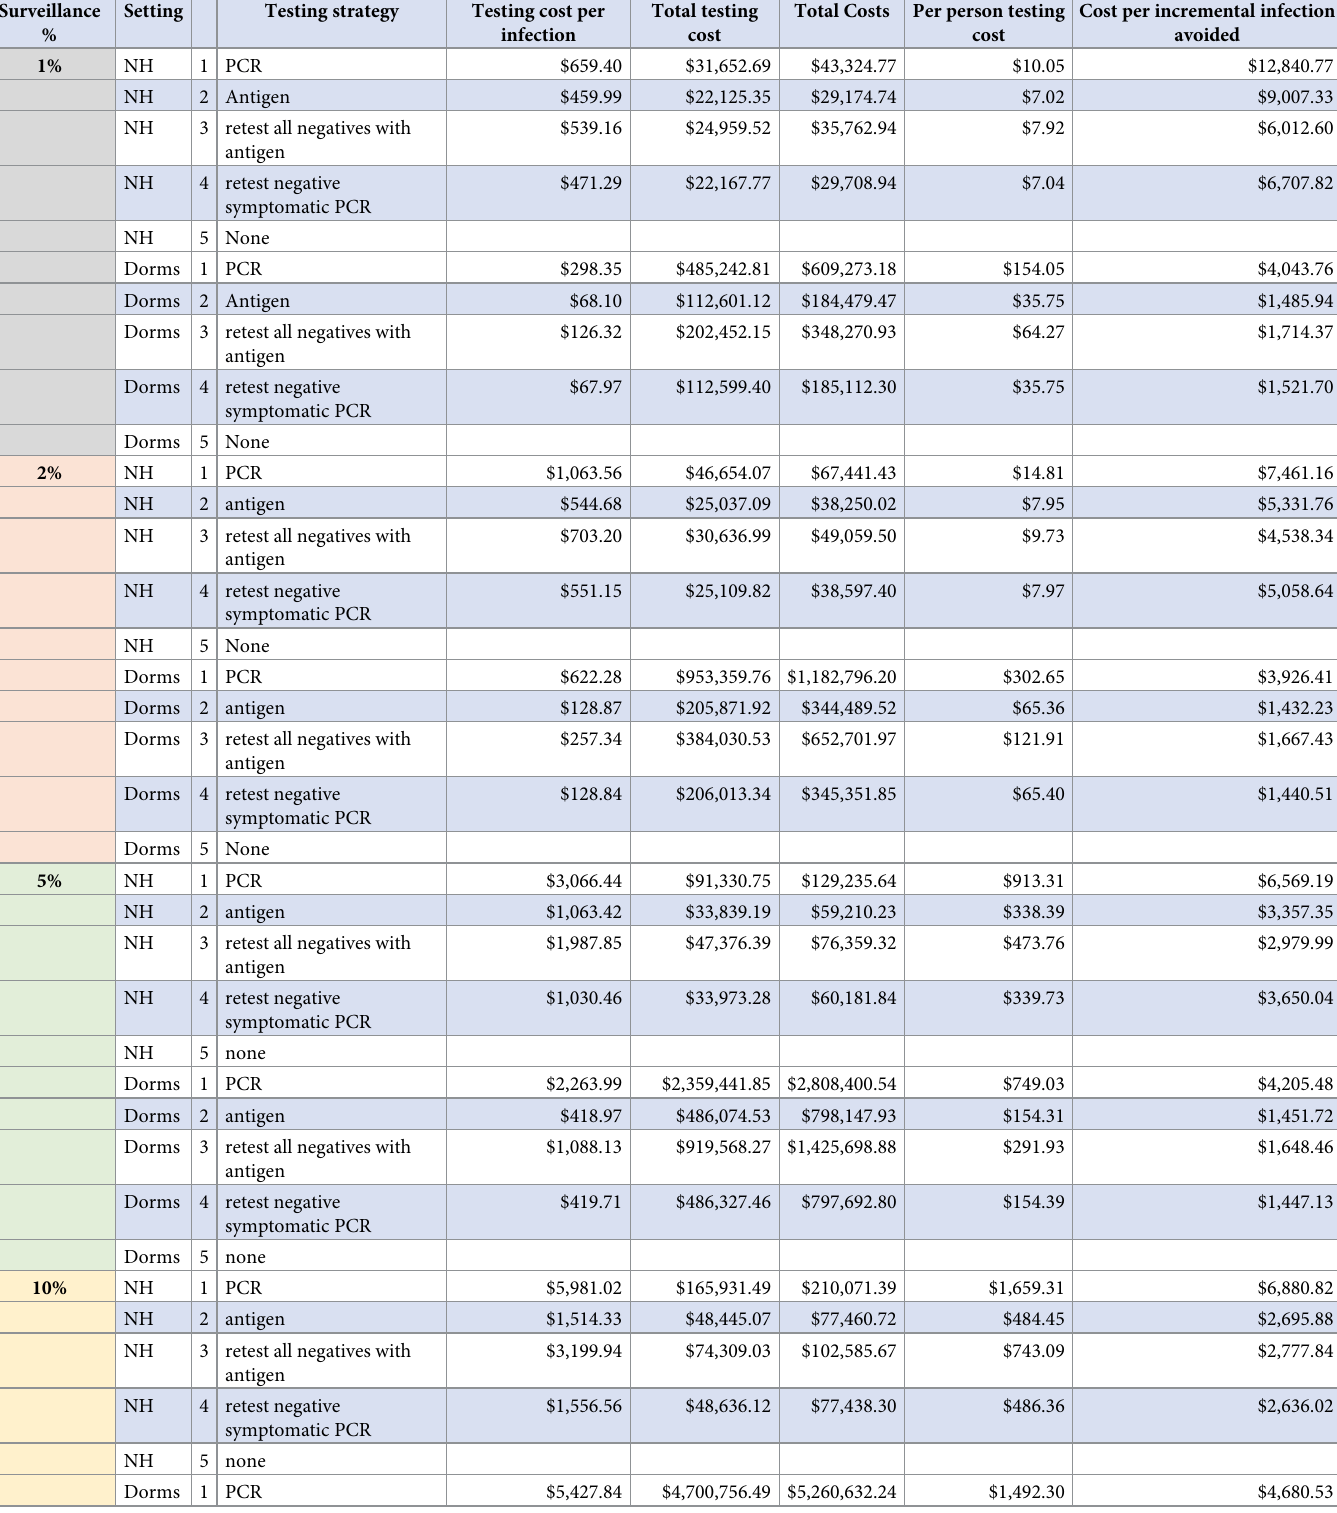
Table 1. Results of the economic cost analysis. Surveillance